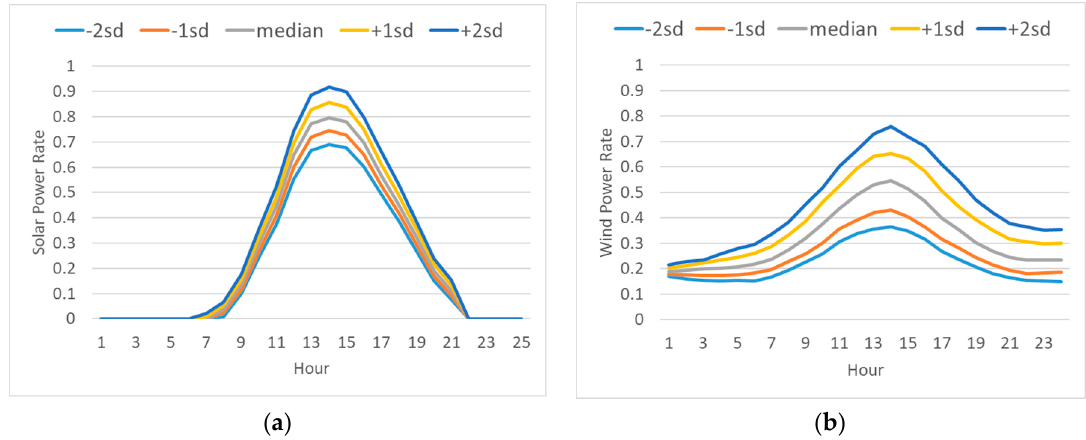
Figure 2. The five representative forecast profiles for sites Solar1 and Wind1: ( a ) Solar1 (Jeju City); ( b ) Wind1 (Hanlim).